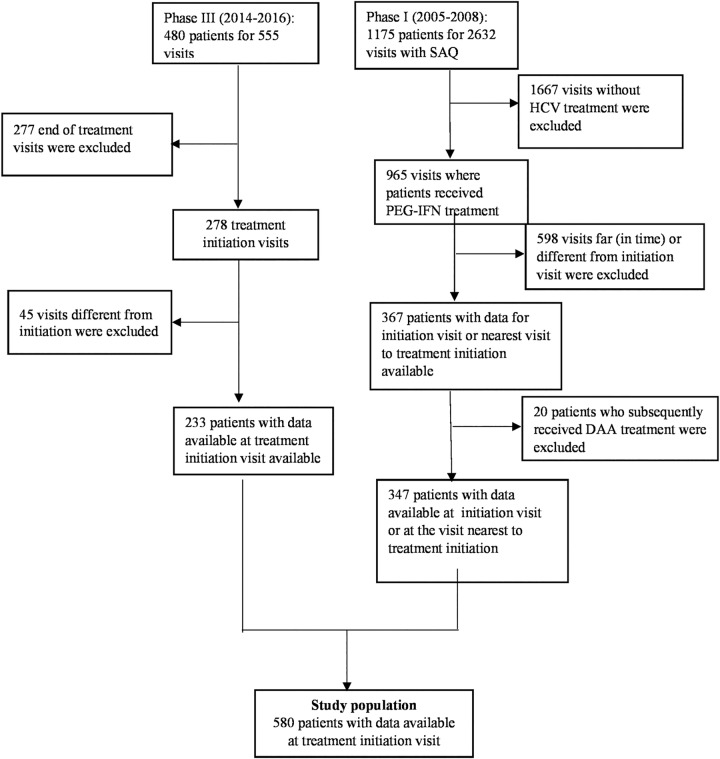
Flow chart of the patients included in the study.